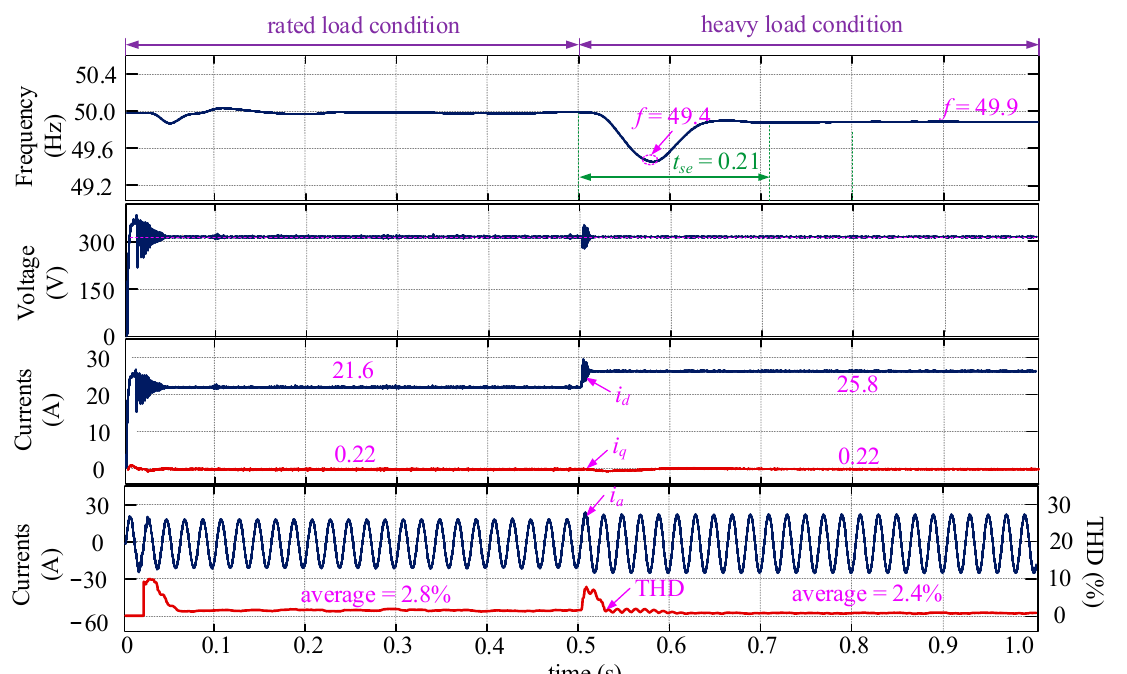
Figure 6. Control performance of the traditional VSG method without parameter mismatch and EV uncertainties considered.